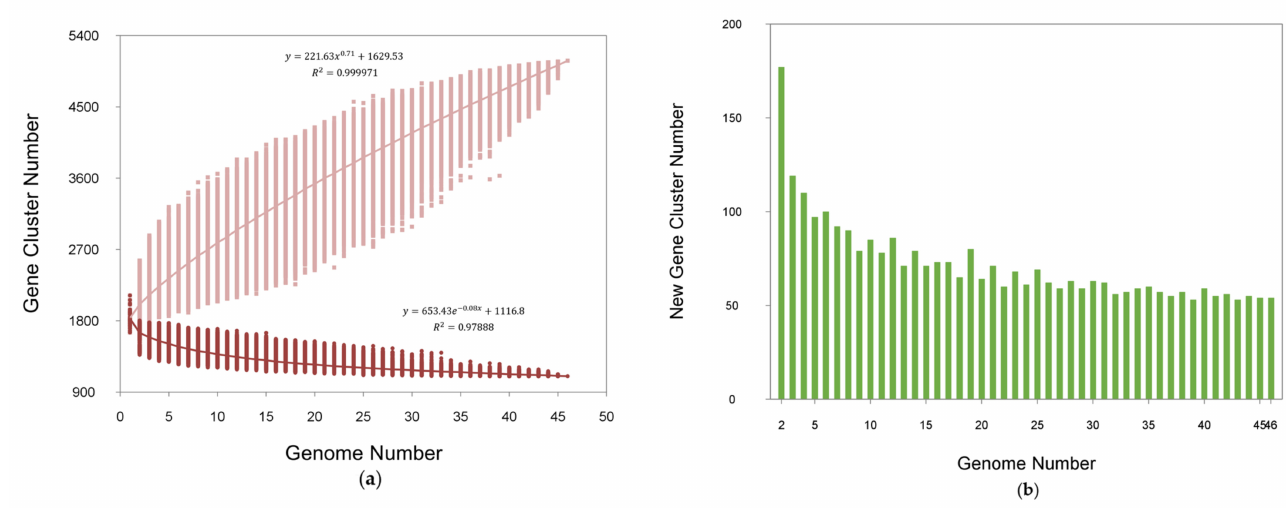
Figure 1. Pan-genome and core-genome of L. acidophilus. ( a ) Pan-genome plot is represented by the accumulated number of new genes against the number of genomes added. Core-genome plot is represented by the accumulated number of genes attributed to the core-genomes against the number of added genomes. ( b ) The new gene cluster number plot shows the changes in new genes of all strains genomes as the number of L. acidophilus strains